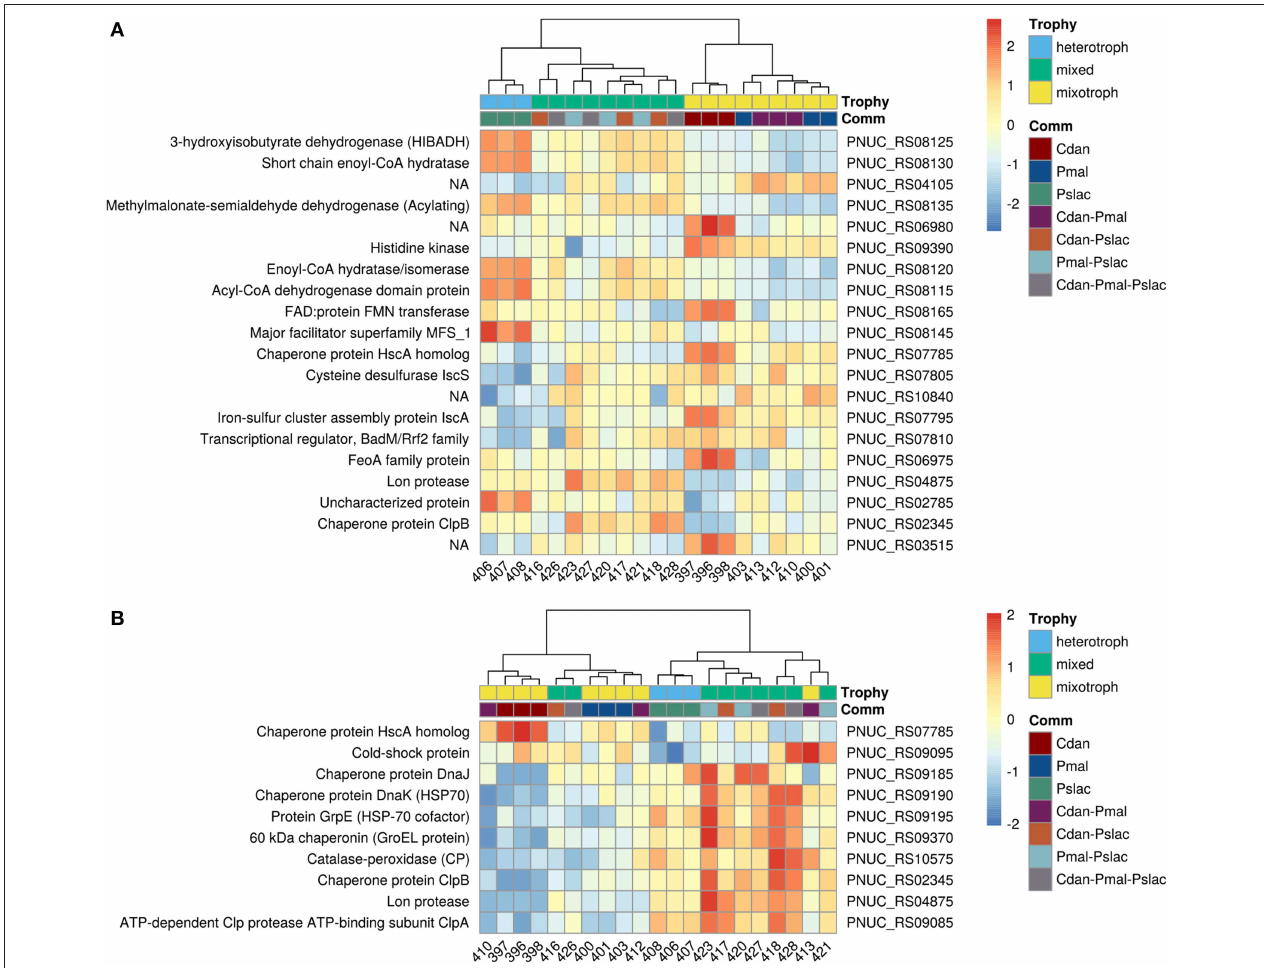
FIGURE 4 | Heatmap of gene expression for Pn. asymbioticus in all samples. (A) Depicts the 20 most differentially expressed genes of 150 between the conditions in single-species samples ordered by Benjamini-Hochberg adjusted p -value. (B) depicts significant differentially expressed genes which are annotated to stress responses. The heatmaps show the z-transformed normalized read counts on log2 scale clustered using hierarchical clustering with the Ward-D2 method and euclidean distances (correlation distances yield the same clustering). The dendrograms are depicted above the heatmaps. As annotation of the samples the protistan community and the trophic mode of the community members is indicated below the dendrograms. In (A) we primarily observe a clustering of samples due to their gene expression according to single- and multi-species community and further a clustering by trophy. In (B) we observe a similar clustering by trophy and community, but with some outliers in the replicates (samples 416, 426, and